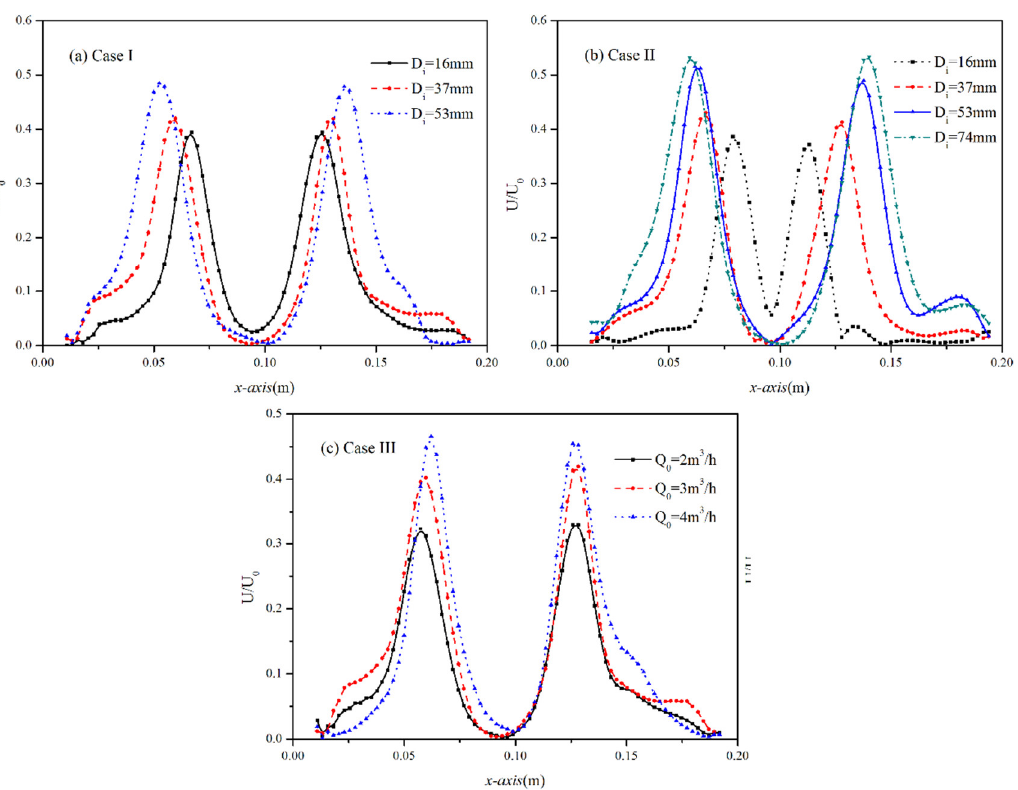
Figure 5. The velocity ratio (U/U 0 ) along the centerline under three cases.